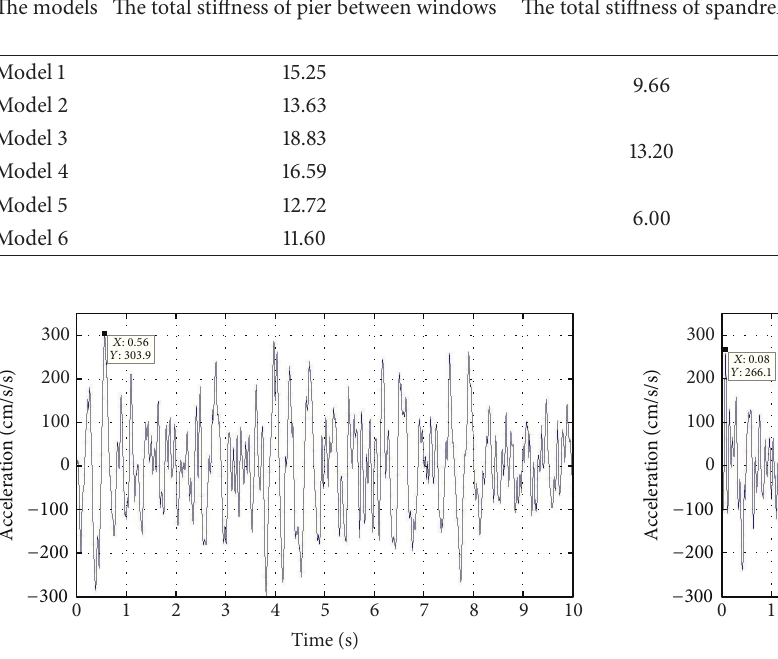
Figure 13: The time history curve of Lixian County ground motion in 𝑋 direction.